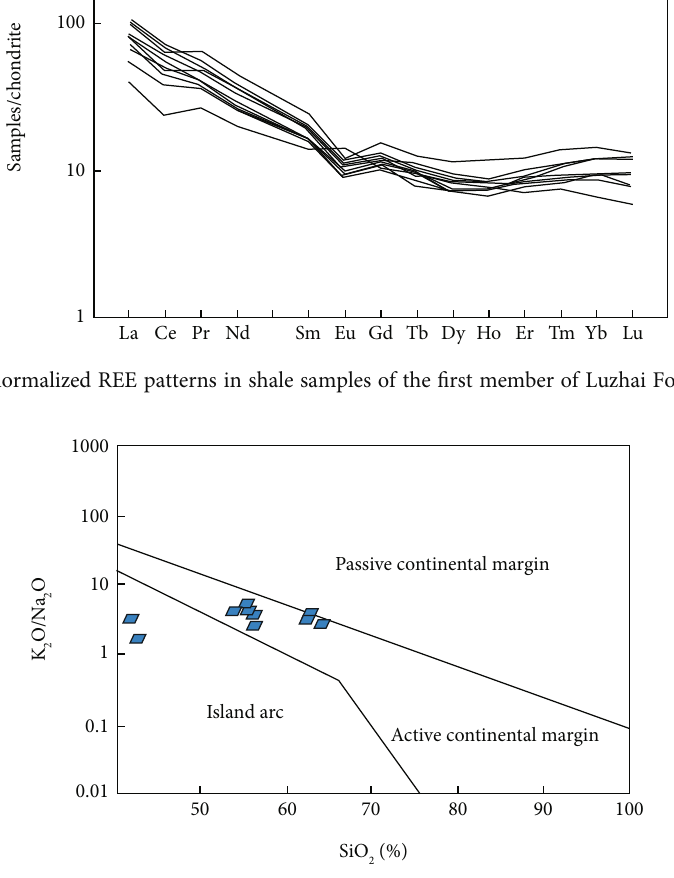
-(K O/Na O) tectonic discrimination diagram in Rongshui, Guangxi [41]. 2 2 2